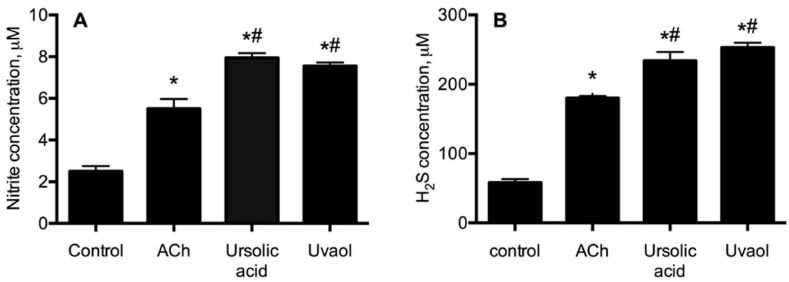
Figure 7. Total nitrite ( A ) and hydrogen sulfide ( B ) concentration induced by stimulation of aortic tissue with ursolic acid and uvaol. Statistical analysis was made using a one-way ANOVA, followed by a Tukey’s test (* p < 0.0001 vs. control; # p < 0.05 vs.